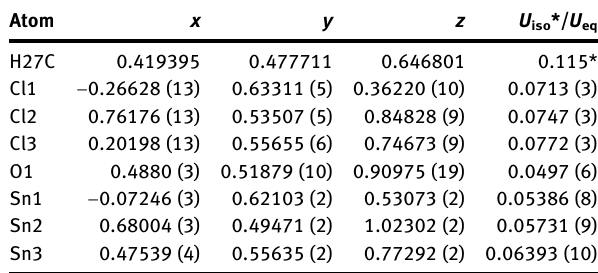
Table  : Fractional atomic coordinates and isotropic or equivalent isotropic displacement parameters (Å 